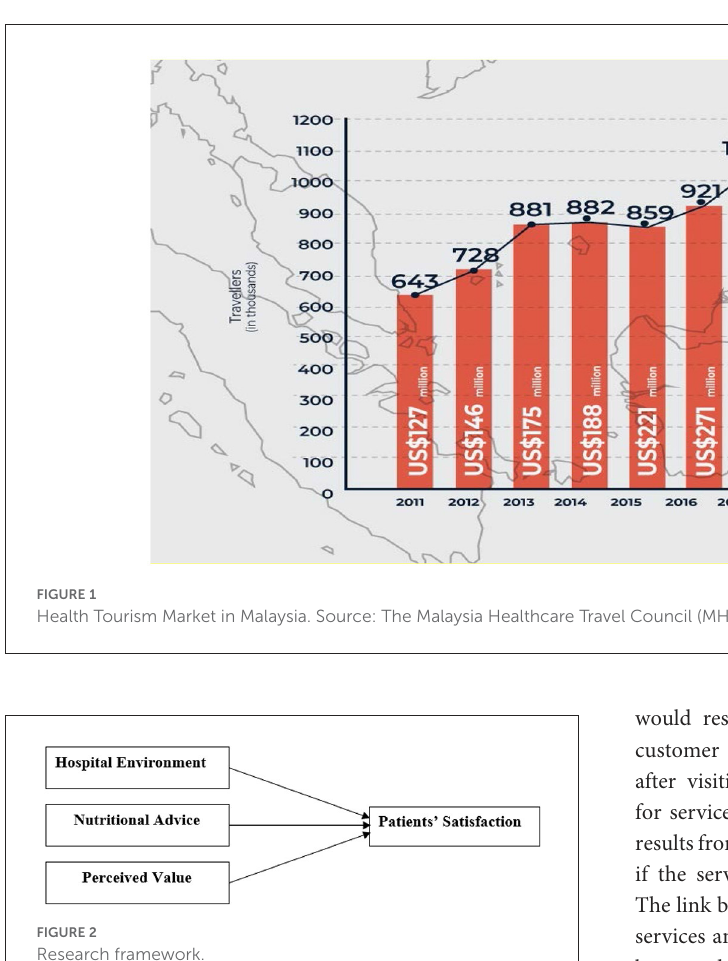
FIGURE2 Research